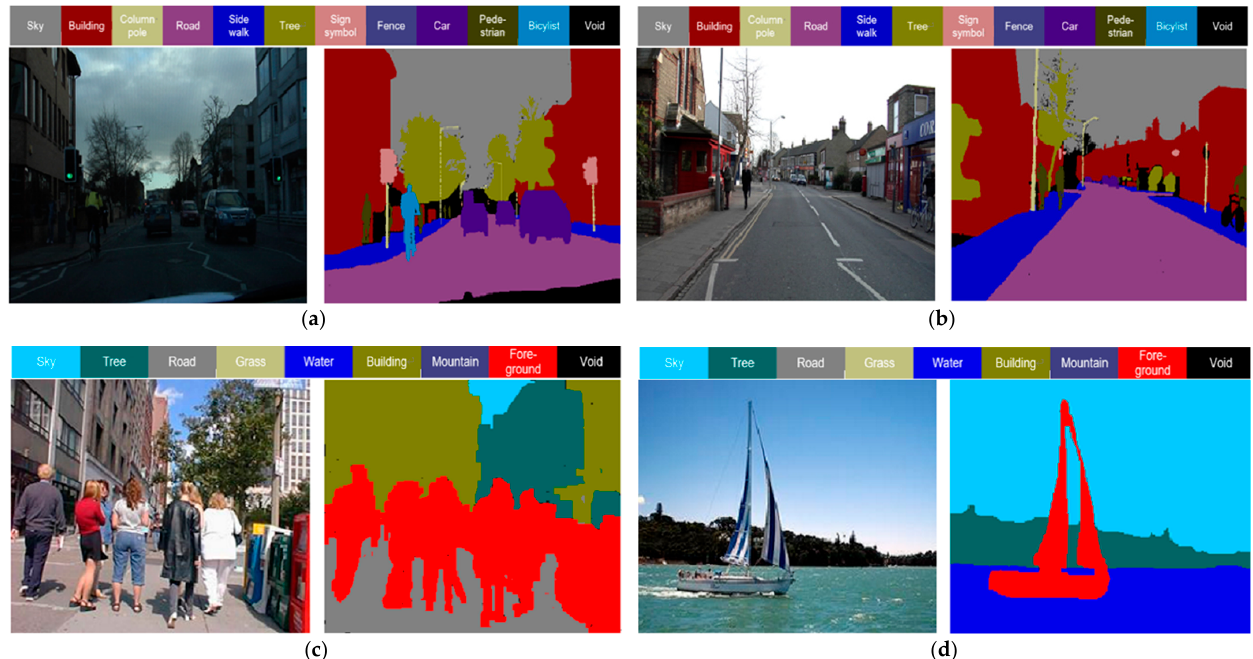
Figure 4. Examples of experimental databases: ( a , b ) CamVid; ( c , d ) SBD; In ( a – d ), the left and right images show the input and ground-truth images, respectively.